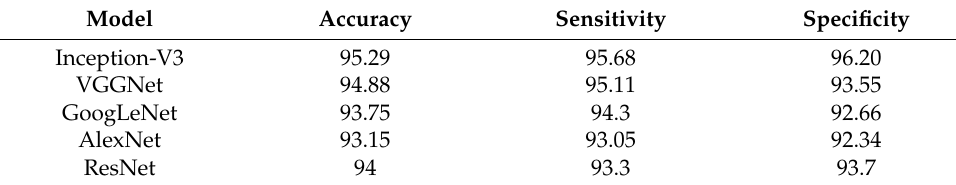
Table 6. Performance of the proposed GWO-IV3.